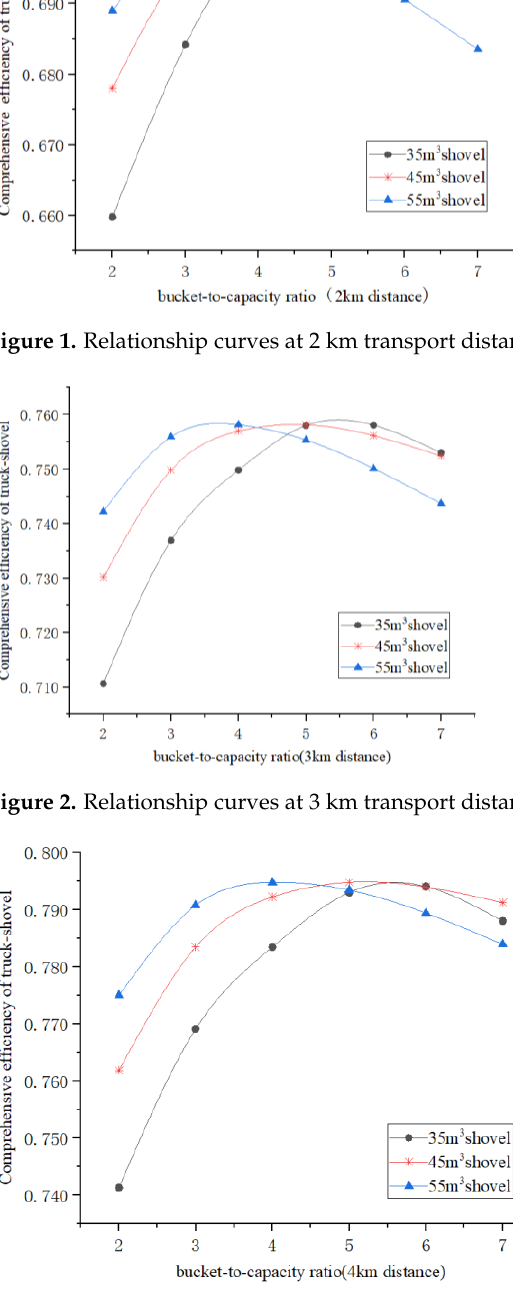
Figure 4. Relationship curves at 5 km transport distance. According to the analysis in Figures 1 – 4, the best bucket-to-capacity ratio is related to the bucket size and transport distance. With the increase of bucket size, the best bucket- to-capacity ratio decreases, while the transport distance increases, the best bucket-to-ca- pacity ratio gradually increases, and the best bucket-to-capacity ratio is mainly distributed in the range of 4 – 5:1. Therefore, for the oversize open-pit mine, the overall economy is better when the 35 m 3 , 45 m 3 and 55 m 3 shovels are used and the bucket-to-capacity ratio is 4 – 5:1. However, the best bucket-to-capacity ratio should be determined comprehen- sively according to the truck-shovel efficiency model curve based on the transport dis- tance of the mine. Accordingly, truck specifications suitable for matching 35 m 3 , 45 m 3 and 55 m 3 shov- els can be calculated, and the results are shown in Table 4. Table 4. Truck matching for different shovel specifications. Shovel Specifications